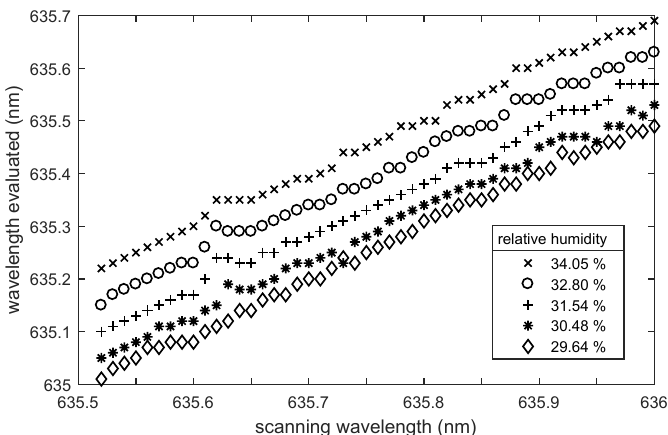
Figure 5. Determined wavelength compared to the laser scanning wavelength for different relative humidity levels. The initial relative humidity was 40.1%, and the array consisted of twenty 74µm